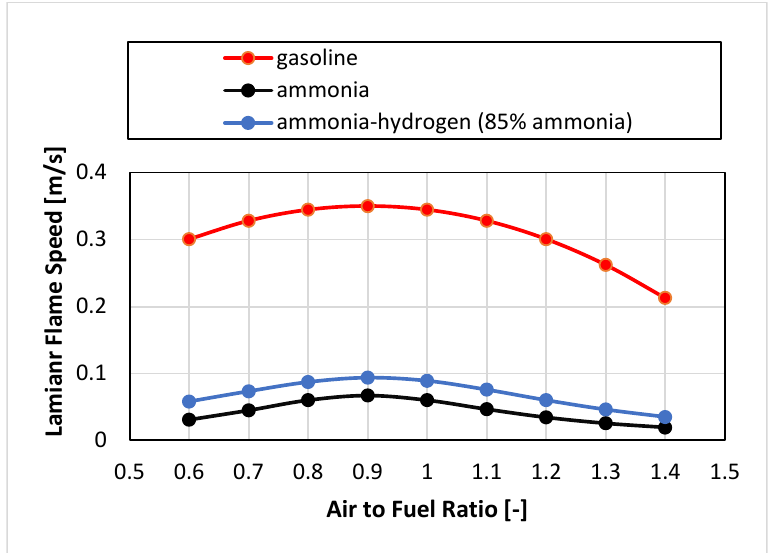
Figure 2. Laminar flame speed comparison in ambient condition. Data were calculated according to Equations (1) – (5) for ammonia and hydrogen – ammonia blend, according to [34] for gasoline.